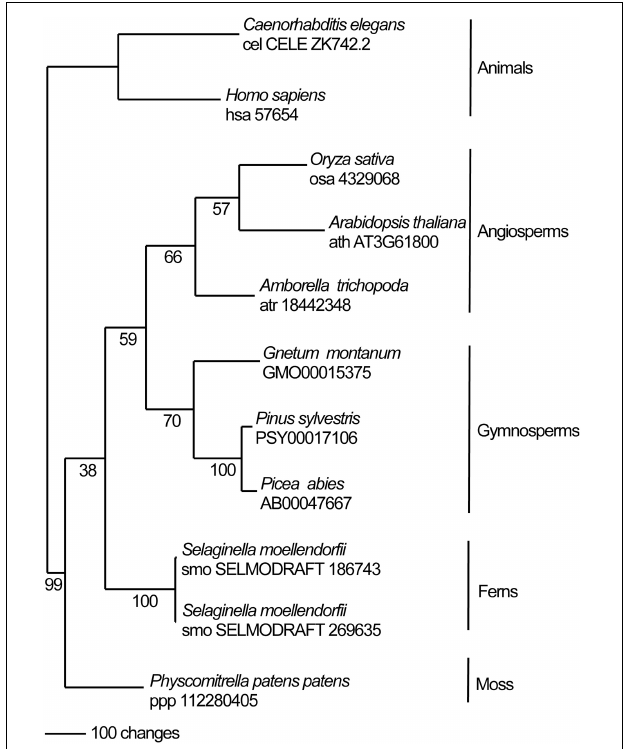
FIGURE 1 | The single most parsimonious phylogenic tree (score 2561) based on analysis of amino acid sequences of UVSSA homologs. Maximum parsimony bootstrap support is indicated under each node. Gymnosperm UVSSA homologs are from the PLAZA gymnosperm site (https://bioinformatics.psb.ugent.be/plaza/versions/gymno-plaza/) (Proost et al., 2015) while all other homologs were accessed via KEGG (Kyoto Encyclopedia of Genes and Genomes)